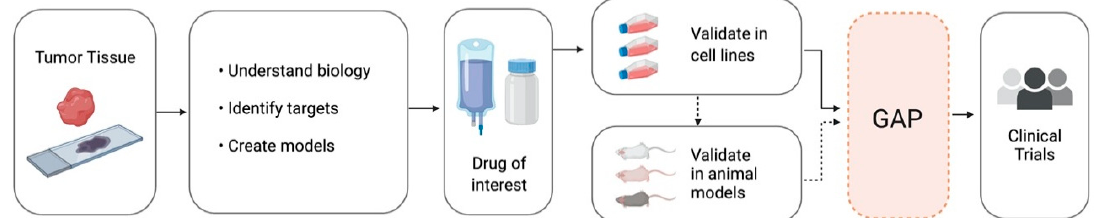
Figure 2. The current pipeline of drug development for central nervous system (CNS) tumors begins with deriving biologic information, therapeutic targets, and models from patient tissue. Then, drugs of interest are identified and validated in cell lines and (ideally, though not always) animal models before moving on to human clinical trials. There is a notable gap in knowledge regarding the ideal dose, route, and schedule for new drugs prior to starting clinical trials. Figure created with BioRender.com.